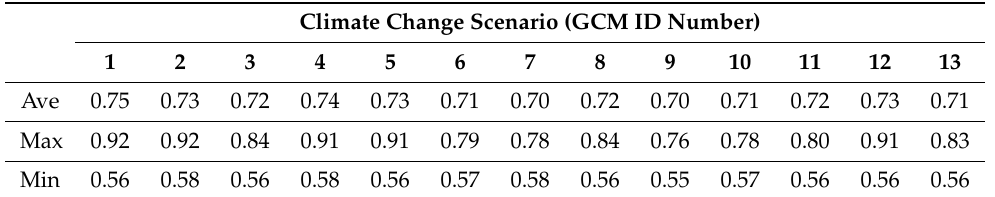
Table 3. Hydrologic risks of the 100-year flood according to the RCP 8.5 (Total Period).